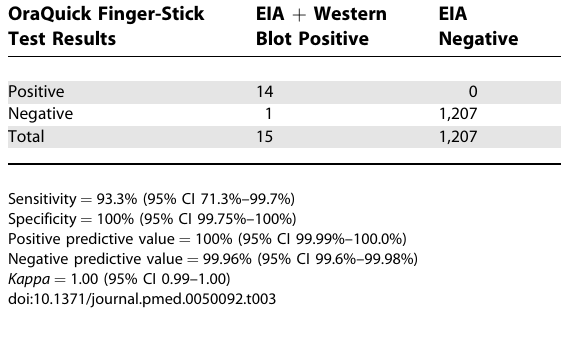
Table 2. Diagnostic Accuracy of OraQuick Oral Fluid Test OraQuick Oral Test Results